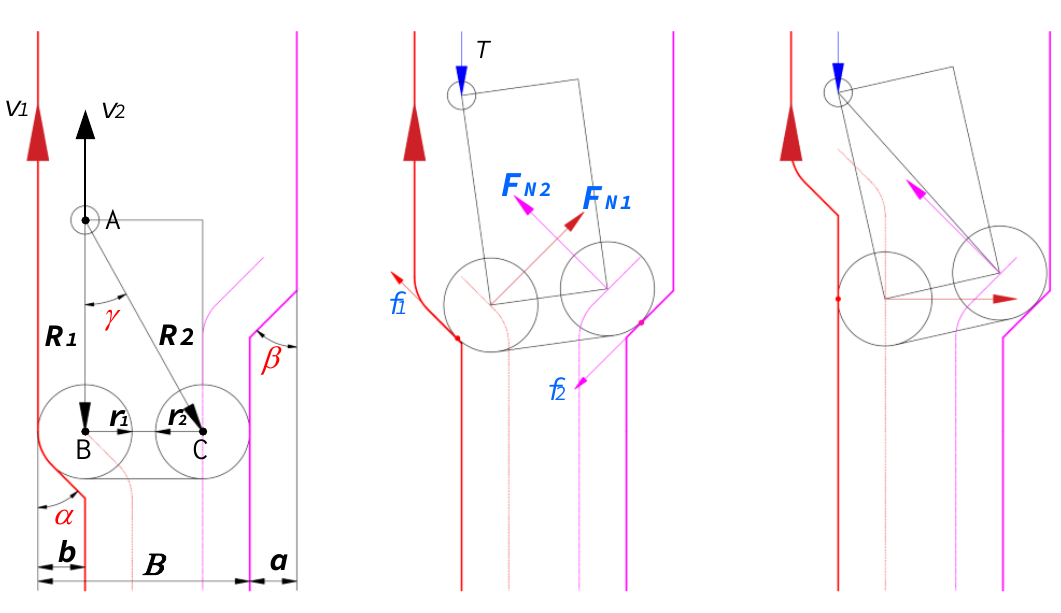
Figure 5. Geometric design of contact pin and force state during action.